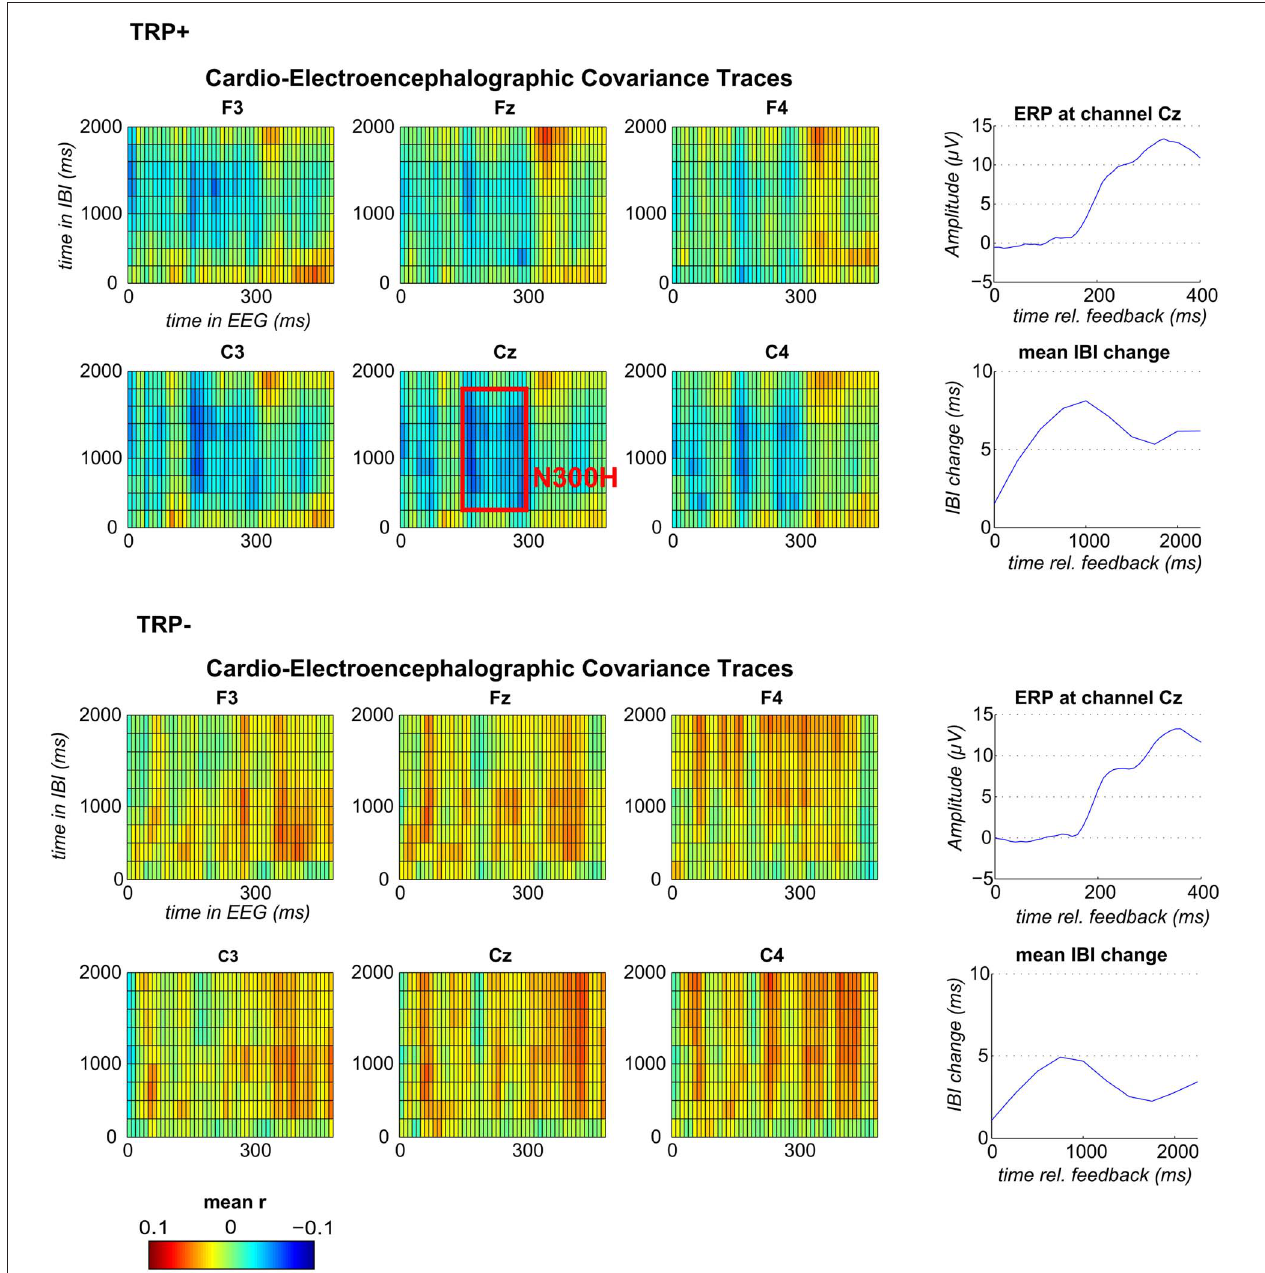
FIGURE 1 | Feedback-locked CECTs, IBI-traces and event-related potentials (ERP) at channel Cz following TRP + (top) and TRP − (bottom). Blue indicates negative and red positive within-subject correlations averaged